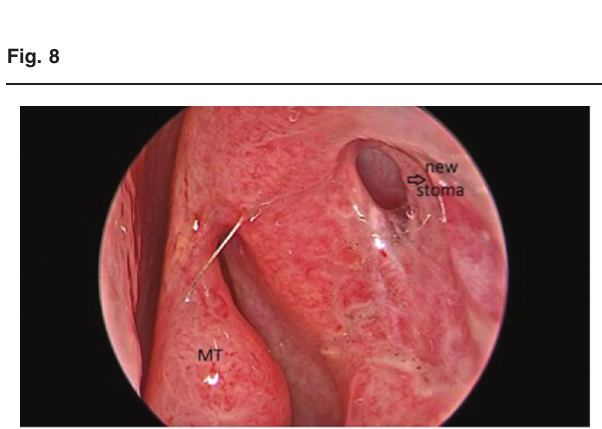
Post-operative views that show will formed lacrimal ostium and tears flow at 6th month post-operative (MT: Middle